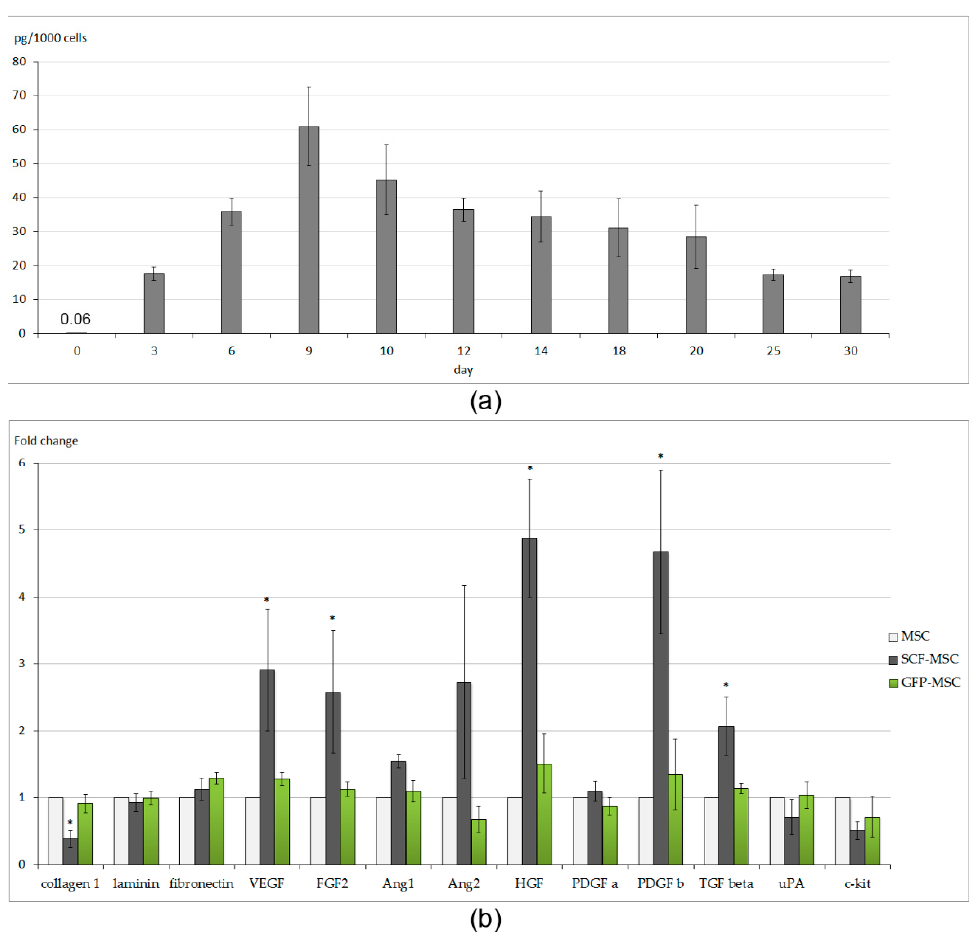
Figure 1. Paracrine and expression activity of SCF-MSC. ( a ) The dynamics of SCF protein level in the conditioned media from SCF-MSC evaluated by immunosorbent assay. The “day 0” bar indicates the basal level of SCF secretion by unmodified MSCs; ( b ) Expression profile (mRNA level) of SCF-MSC compared to unmodified cells or MSCs that were transduced by green fluorescent protein (GFP)-encoding AAV. The black and white bars indicate MSC-SCF CS and MSC CS groups, respectively. Data are presented as mean ± SD; *—vs. control MSCs, p < 0.05.